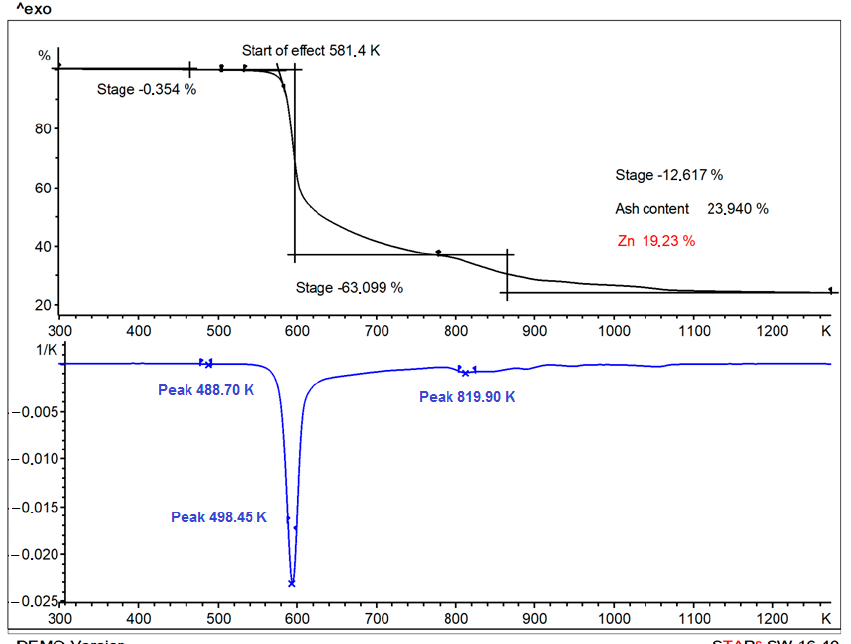
Figure 6. TGA and DTA curves of the synthesized Zn(Met) 2 complex obtained by heating the sample in a static atmosphere of air in the temperature range from 298 to 1273 K.